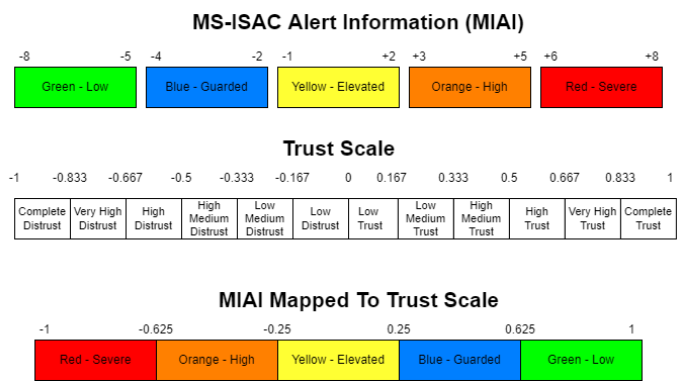
Figure 8. MS-ISAC alert mapped to trust scale [90,111].